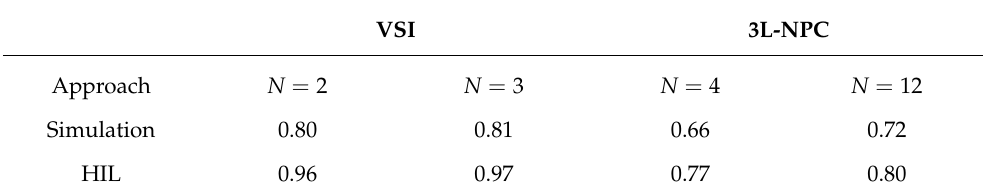
Table 3. Comparison of settling times in